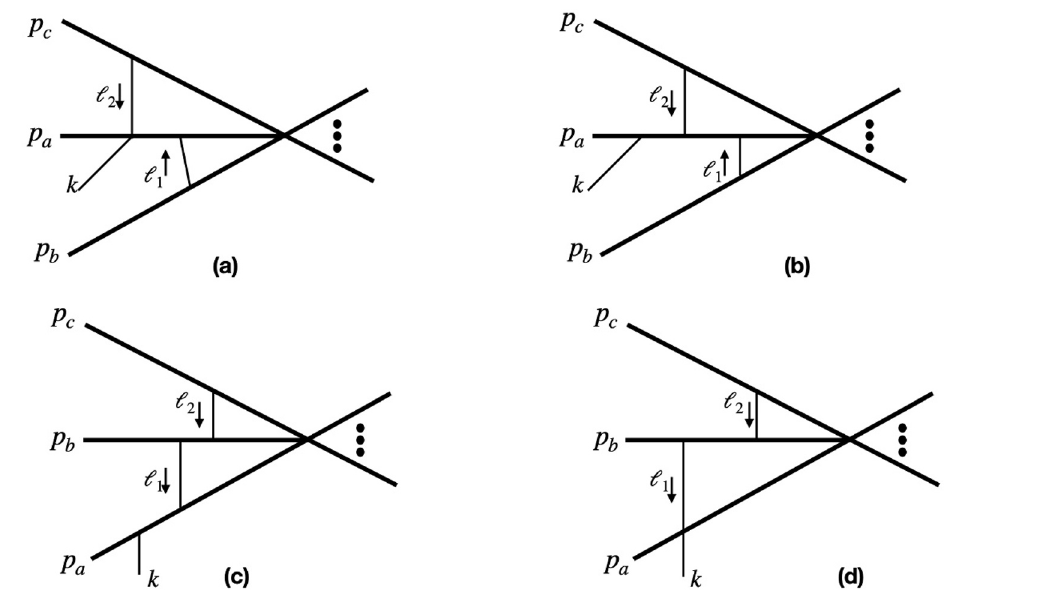
Figure 2 . Sets of two loop Feynman diagrams with two virtual photons connected to three different scalar lines which potentially can contribute to order O ( ω (ln ω ) 2 ) . The thick lines represent massive complex scalars and the thin lines represent photons. Figure 3 . Sets of two loop Feynman diagrams with two virtual photons connected to two different scalar lines which potentially can contribute to order O ( ω (ln ω ) 2 ) . The thick lines represent massive complex scalars and the thin lines represent